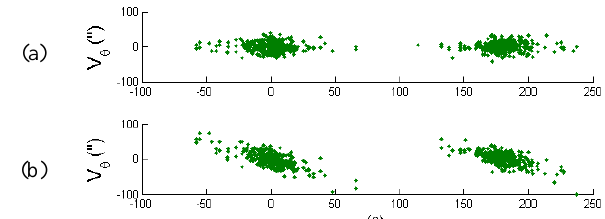
Figure 6: (a) Horizontal angle residuals versus vertical angle plot in point-based self-calibration for panoramic scanners without systematic errors. (b) Unmodelled 1’ trunnion axis error.